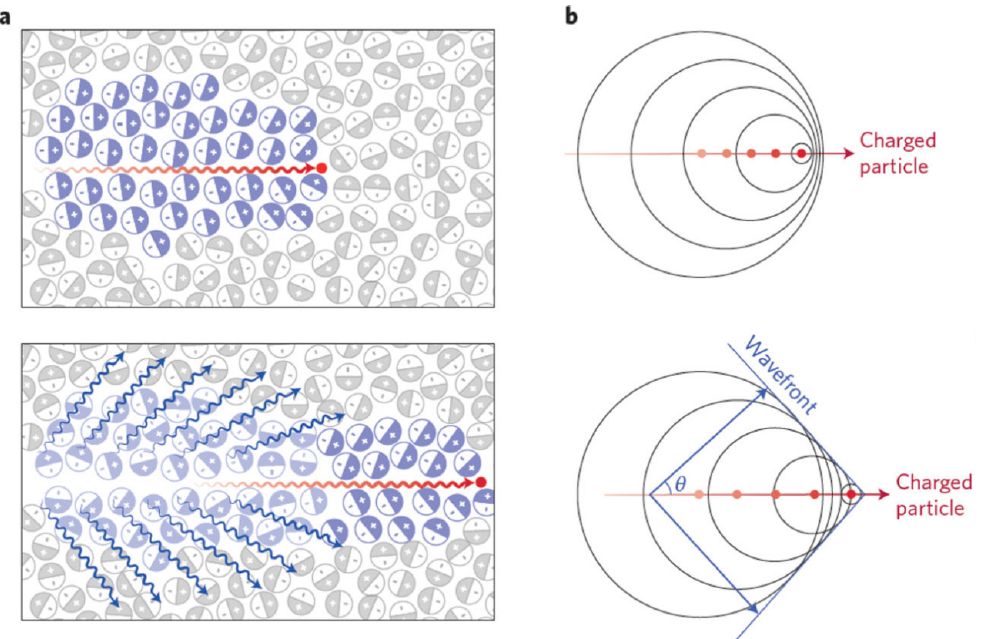
Figure 1. The generation of Cherenkov luminescence (CL). ( a ) Top: A charged particle (red dot) travelling faster than light in a medium polarizes the medium. Bottom: As the medium returns to the ground state, CL (blue wavy lines) is emitted in a forward direction. ( b ) Top: Analogous to a sonic boom, coherent waves are produced through the Cherenkov mechanism, thereby leading to a photonic wavefront. Bottom: As the particle travels forward, the photonic wavefront propagates at a forward angle θ with light being emitted in the direction of travel. Adapted with permission from Ref. [69] 2017 Springer Nature.